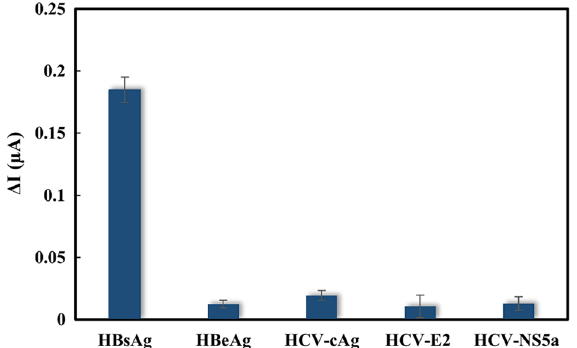
Figure 4. Cross-reactivity of the proposed HBsAg electrochemical immunosensor.